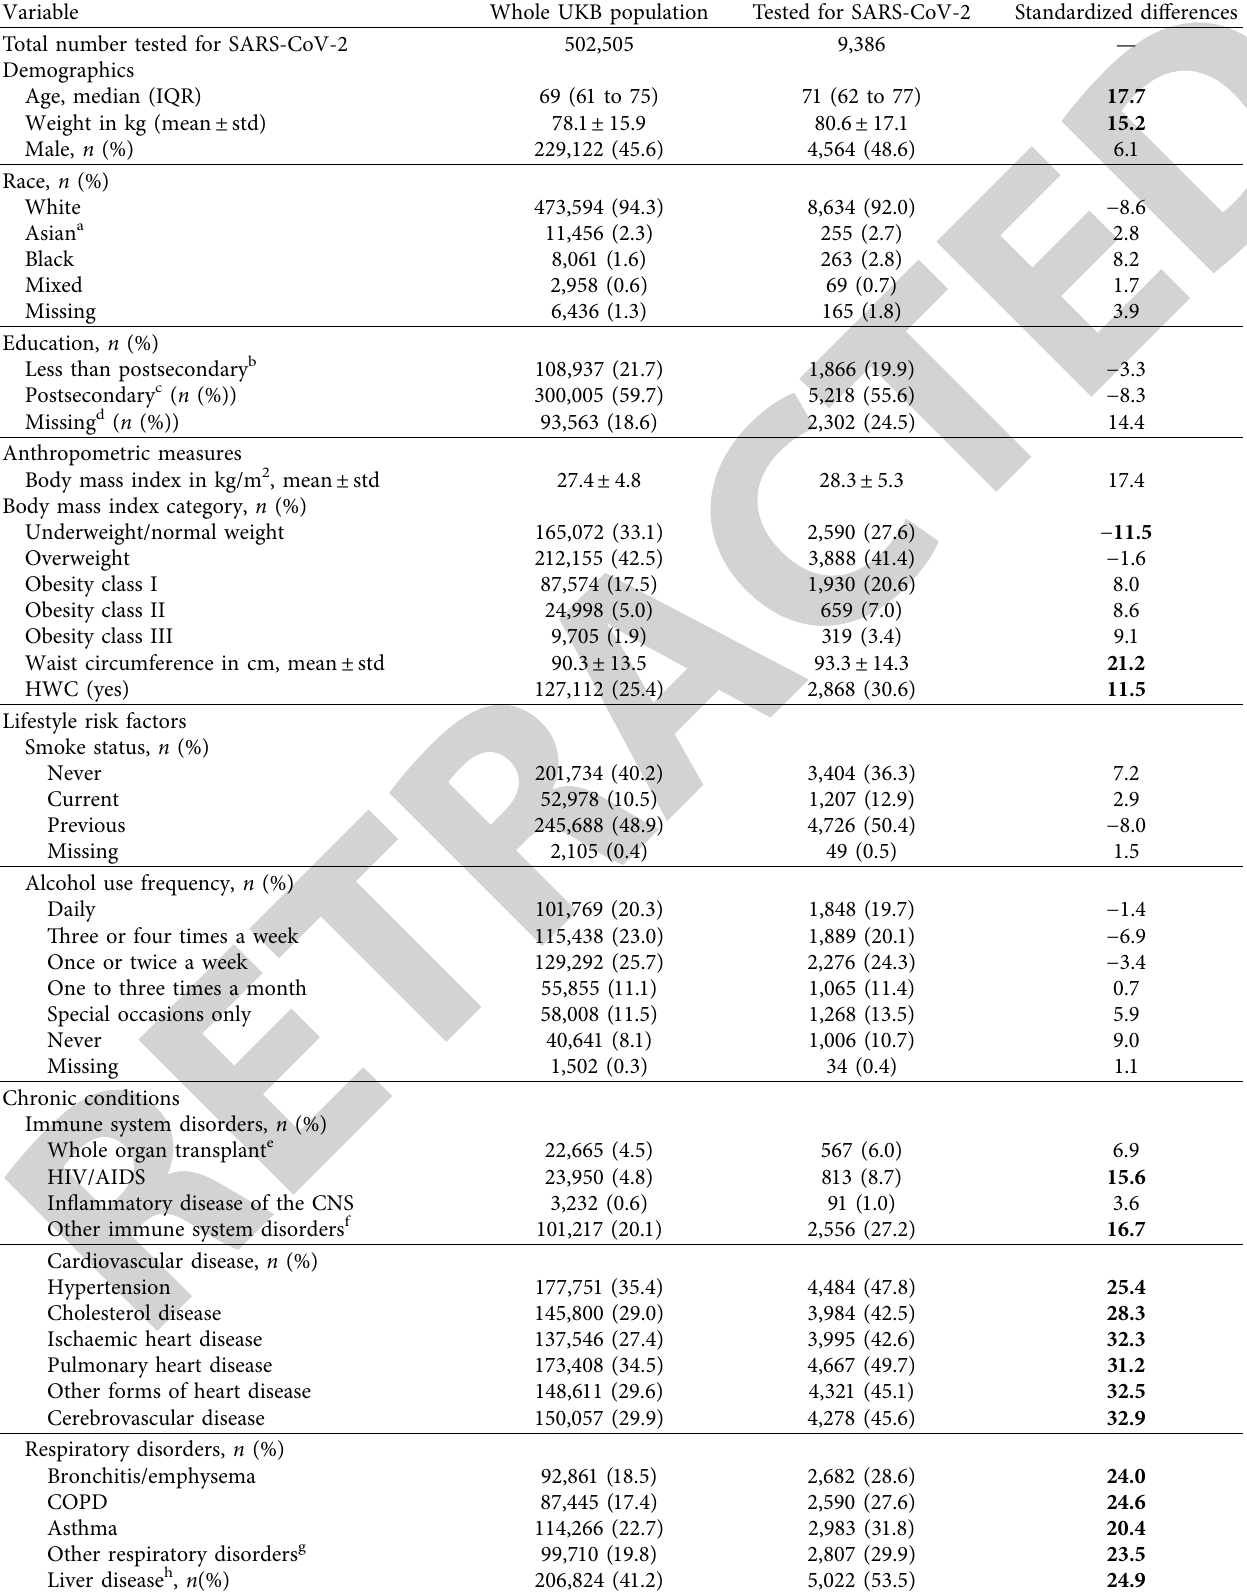
Table 2: Characteristics of the individuals tested for SARS-CoV-2 compared to the full UKB population. Variable Whole UKB population Tested for